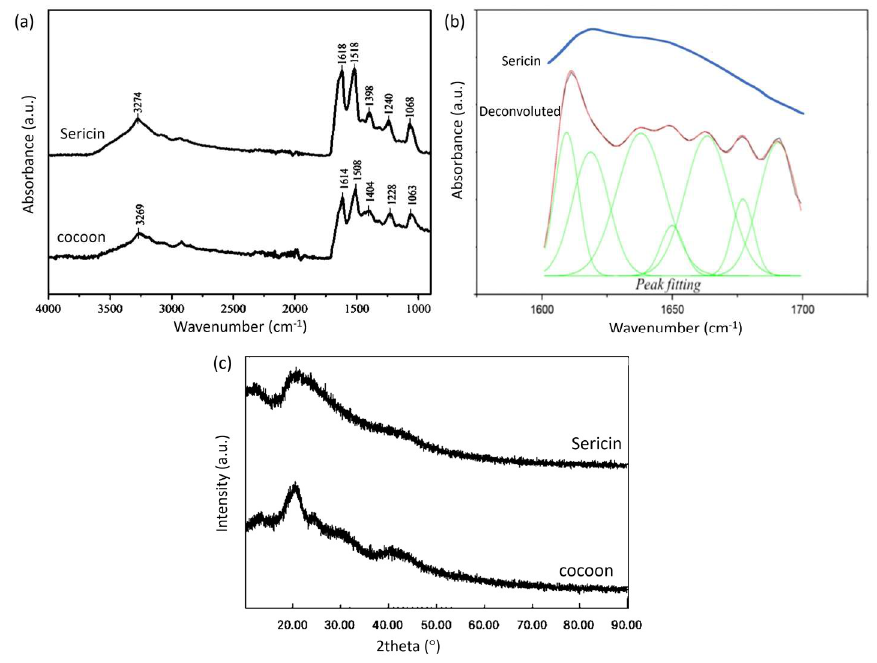
Figure 1. ( a ) FTIR spectra of cocoon and sericin ( b ) Fourier deconvolution results and Gauss peak fitting from the absorption of the amide group I of the FTIR spectrum of sericin ( c ) XRD patterns of cocoon and sericin.